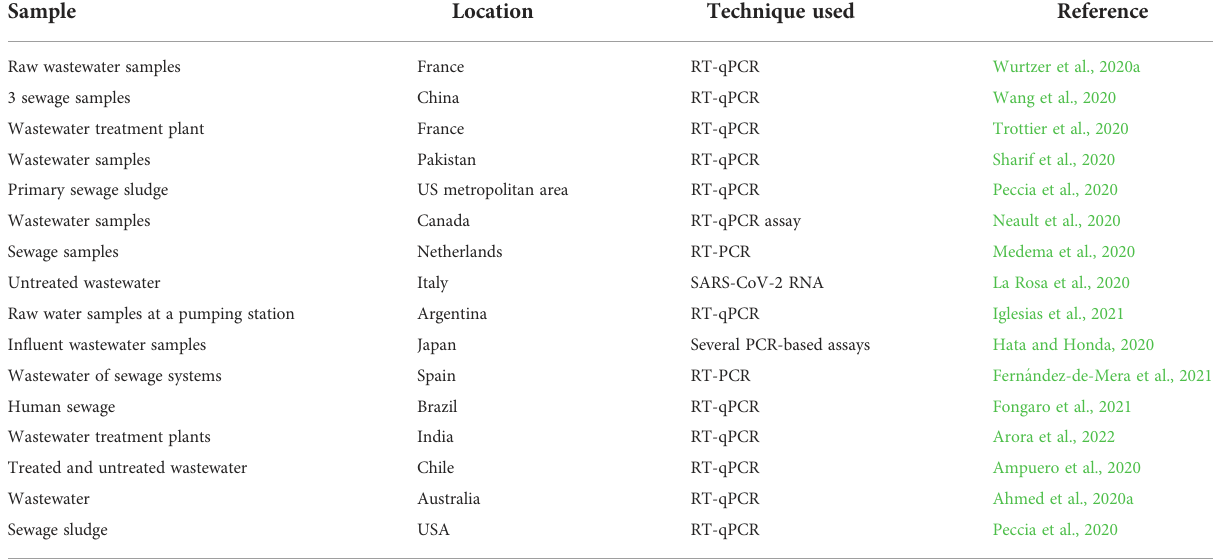
TABLE 3 Worldwide studies on wastewater surveillance.